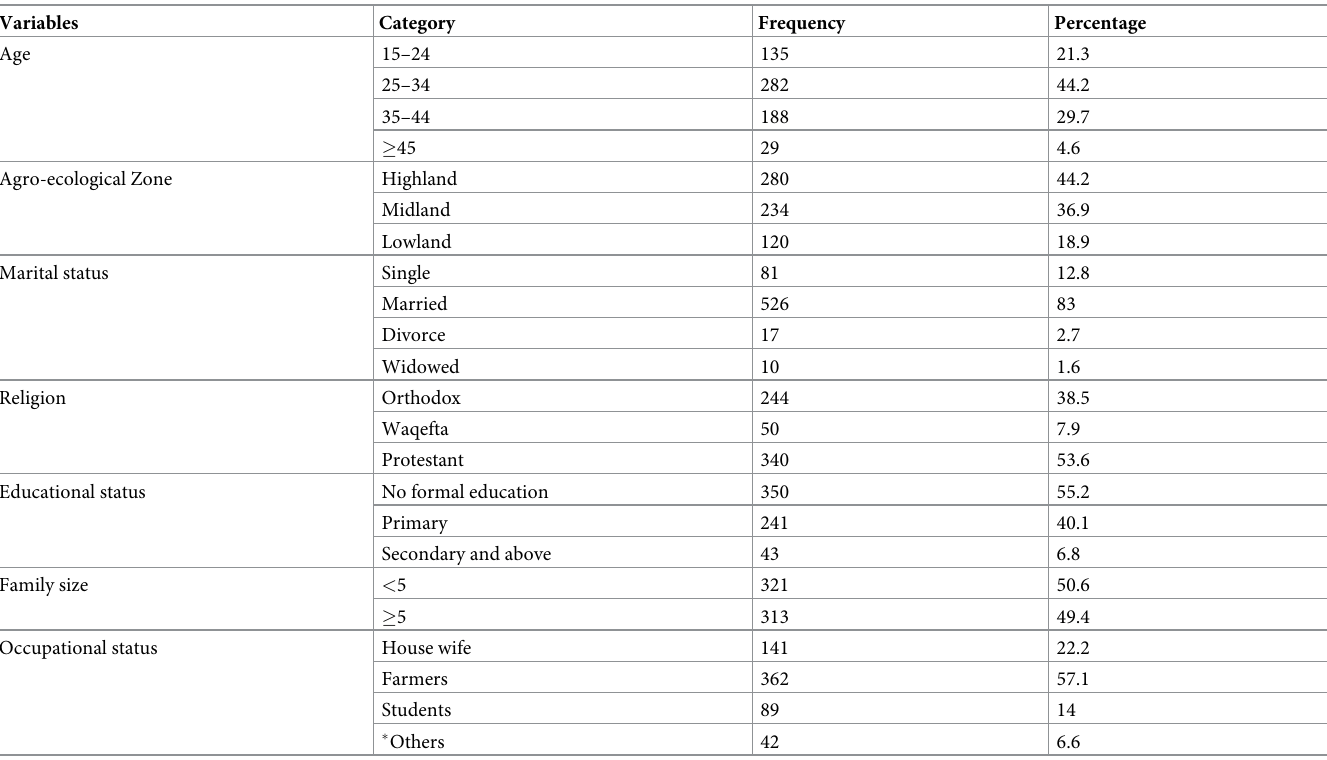
Table 1. Socio-demographic characteristics of reproductive women in Jeldu district West Shoa zone, Oromia, Ethiopia, March 25 –April 15,